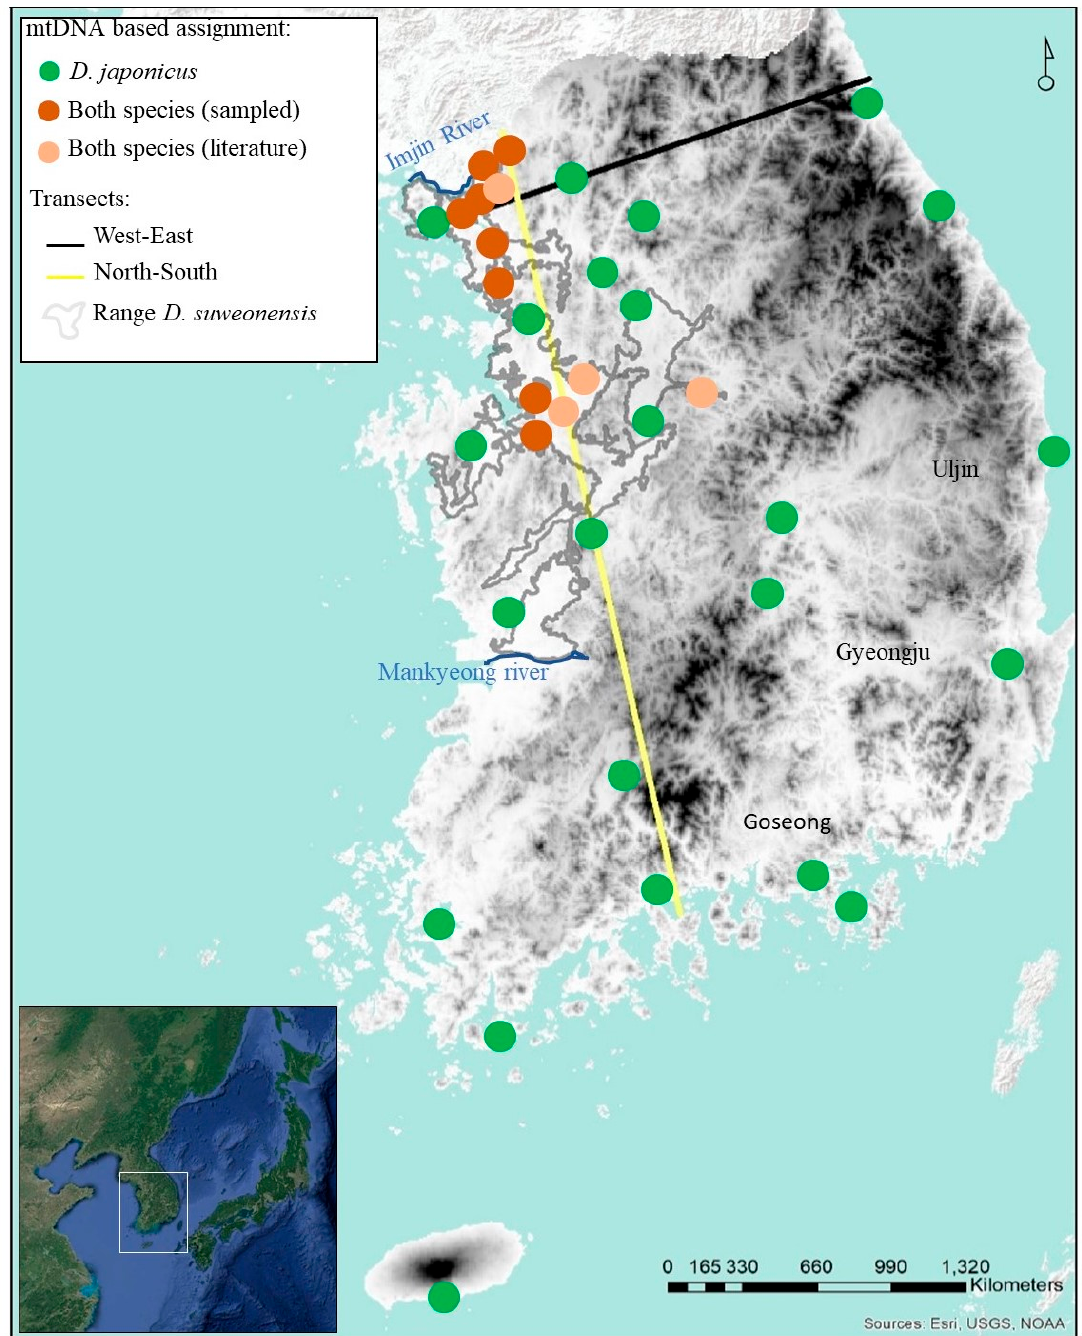
Figure 1. Sampling localities for all Dryophytes individuals in the Republic of Korea. Despite having sampled Dryophytes suweonensis only at some sites, later independent aural surveys indicated the presence of Dryophytes japonicus as well. Two transects across South Korea (west–east and north–south) were selected for subsequent genetic analyses on a subset of the samples (see details in Section 2.4 of the Materials and Methods section). Service layer credits: sources: Esri, United States Geological Surveys, and GeoServicesMap Esri Korea. Map generated in ArcMap 10.5 (Esri, Redlands, CA, USA).